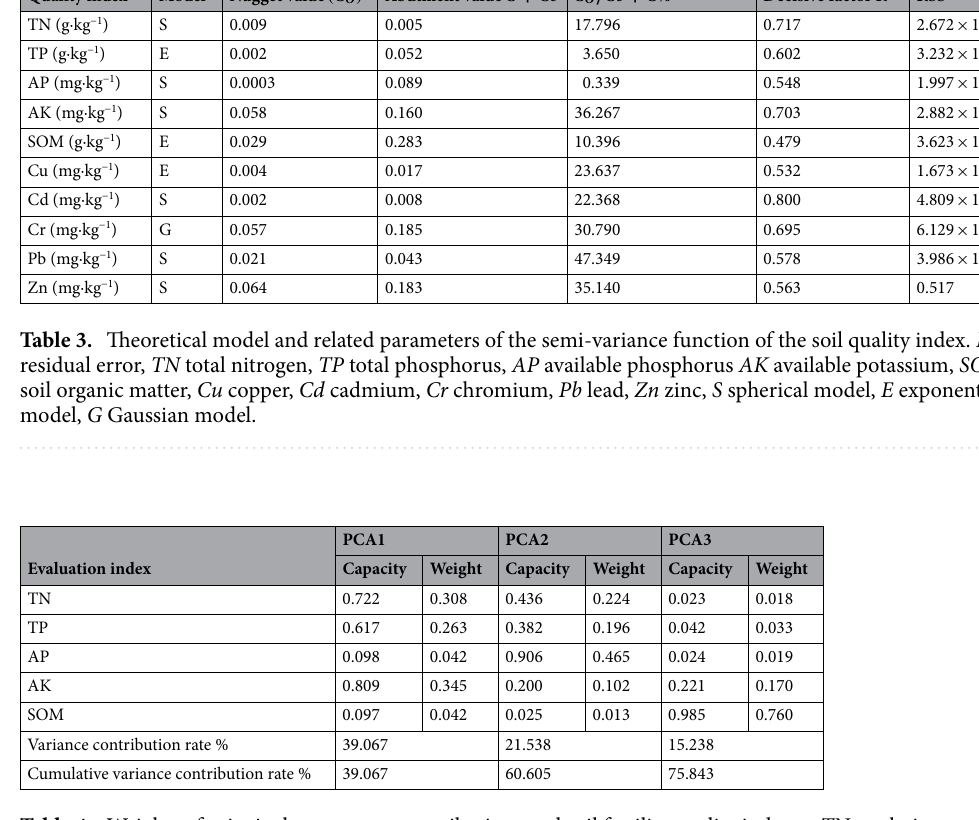
Table 4. Weights of principal component contributions and soil fertility quality indexes. TN total nitrogen, TP total phosphorus, AP available phosphorus, AK available potassium, SOM soil organic